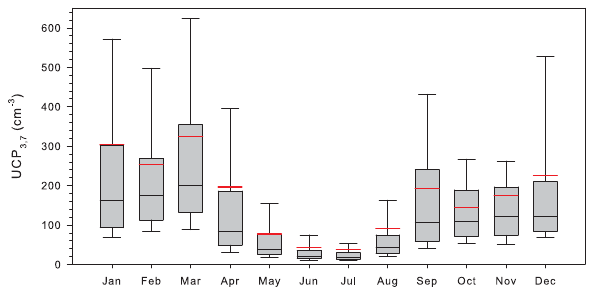
Fig. 6. Notched box plots of the mean seasonality of UCP 3 , 7 con- centrations. For description of the symbols see Fig.